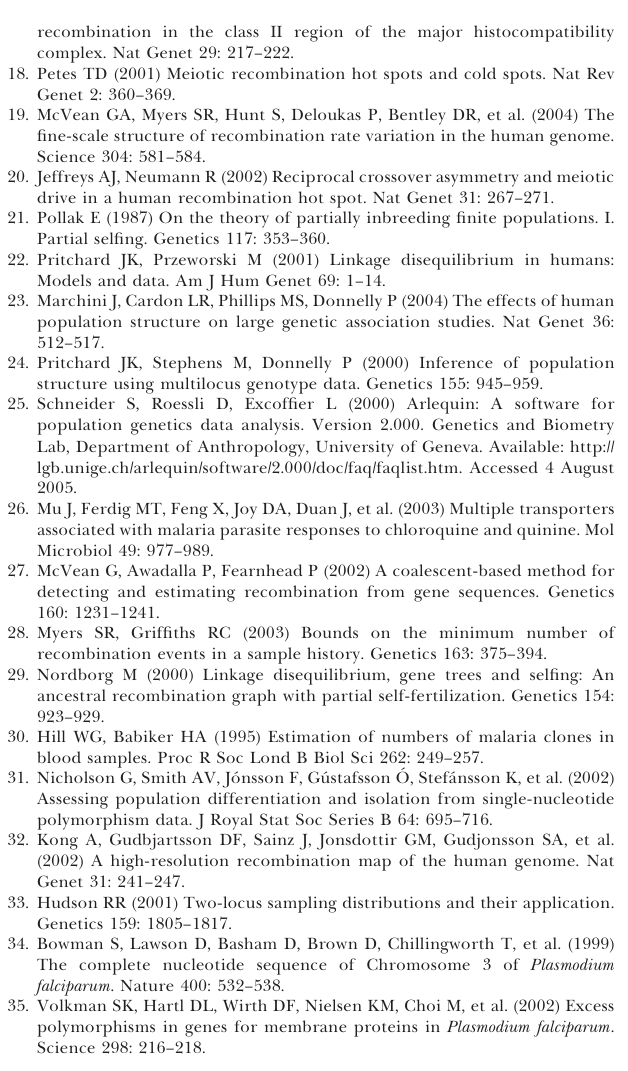
Figure S1. Worldwide Distribution of P. falciparum Isolates Used in this Study Parasites are color-coded as resistant to chloroquine (red), sensitive (black), or not tested (green). Found at DOI: 10.1371/journal.pbio.0030335.sg001 (79 KB PDF). Table S1. Putative Transporter Genes and Their Chromosomal Locations Found at DOI: 10.1371/journal.pbio.0030335.st001 (29 KB